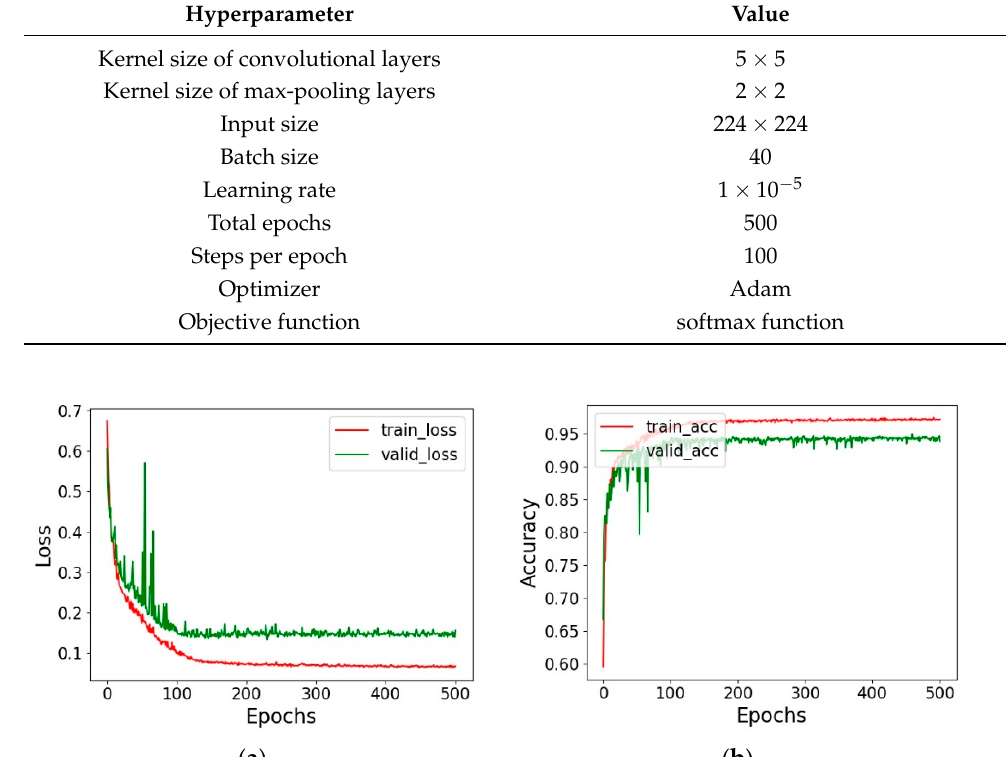
based traffic accident classifier. ( b ) Accuracy of CNN-based traffic accident classifier.